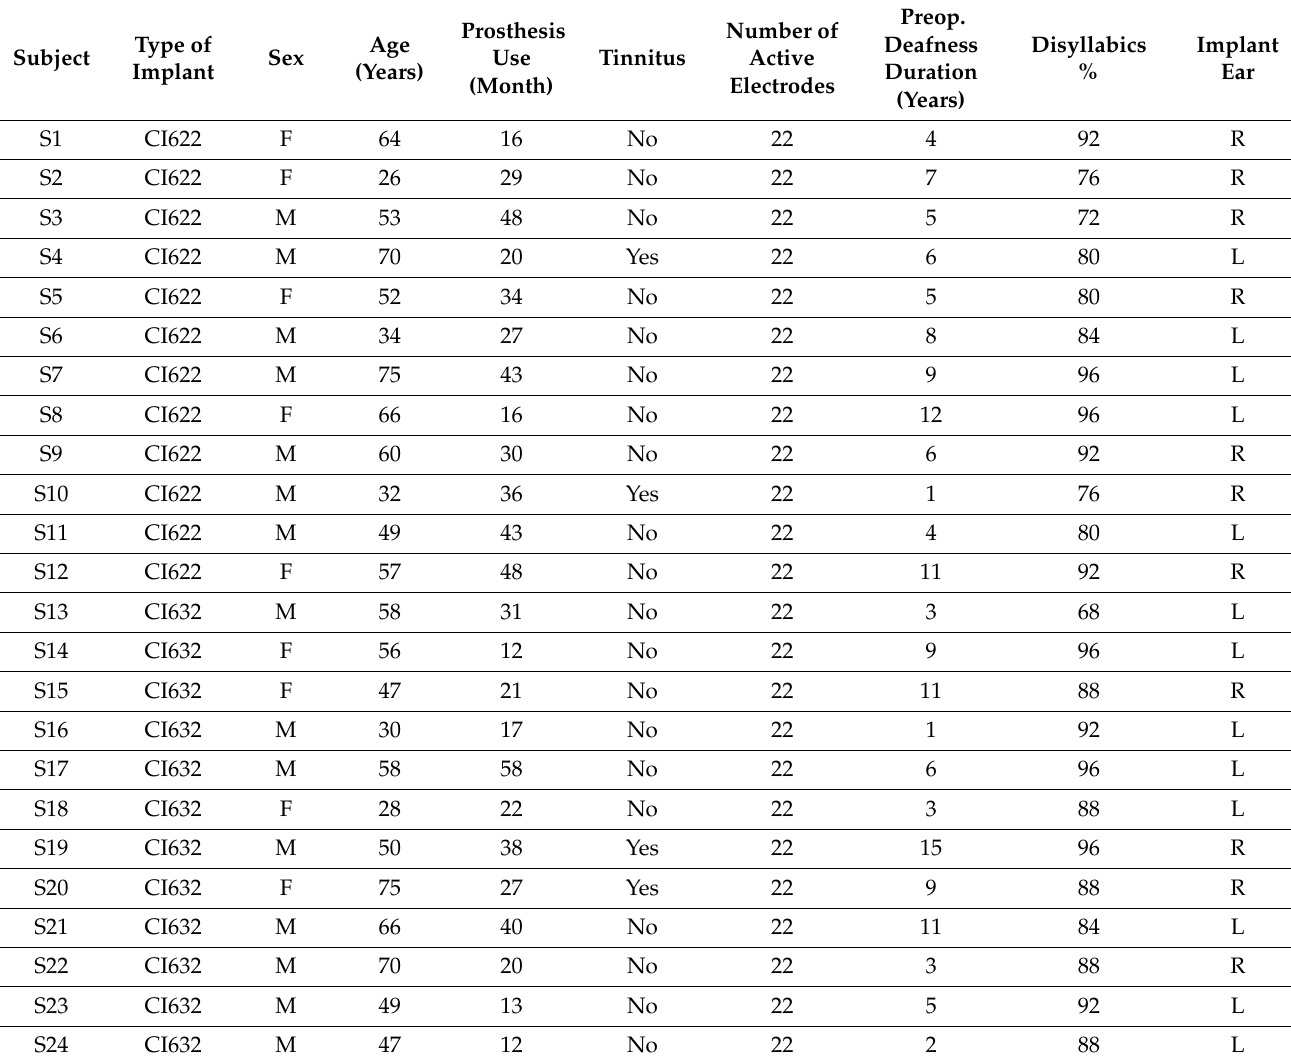
Table 1. Patients’ demographic